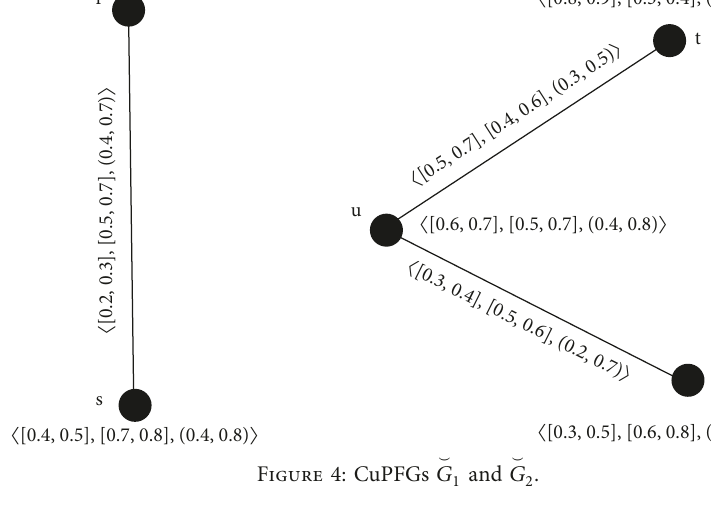
Figure 4: CuPFGs G ⌣